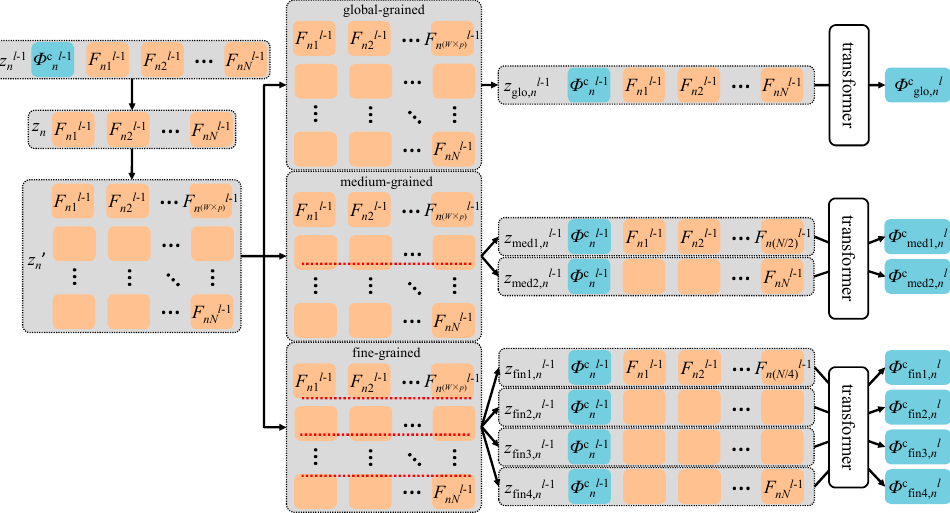
Figure 4. The extraction process of three different kinds of granularity tokens.